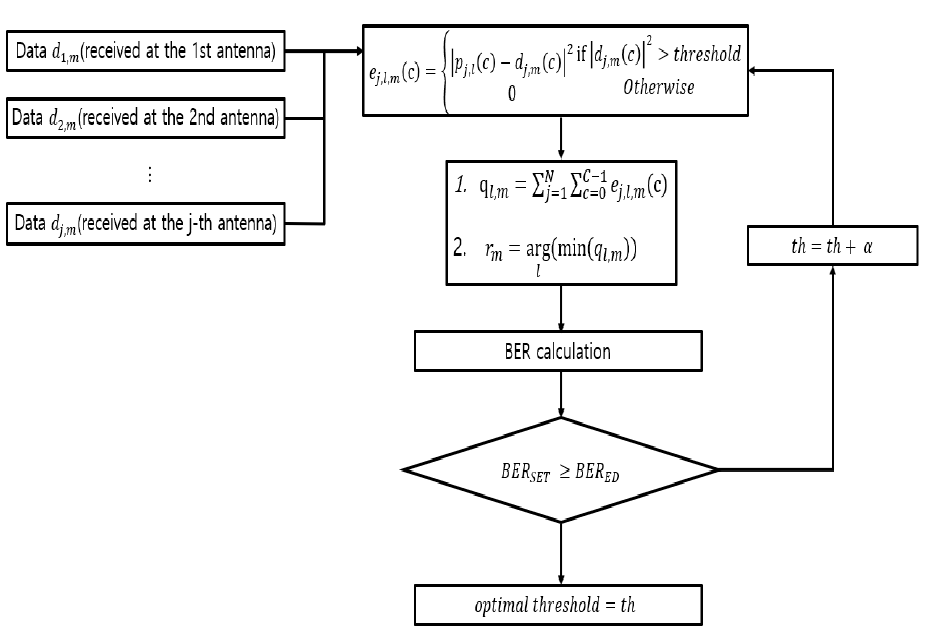
Figure 7. Flowchart for searching the optimal thresholds (SET (subcarrier energy-based threshold) method).